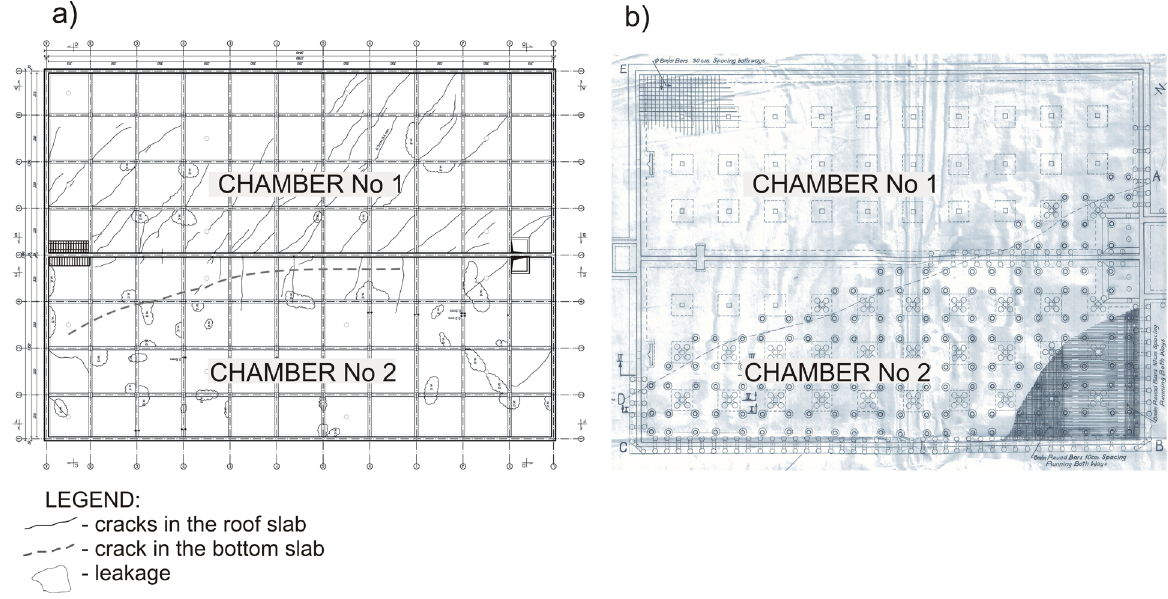
Figure 9: Crack pattern (a) versus region with piles (b).